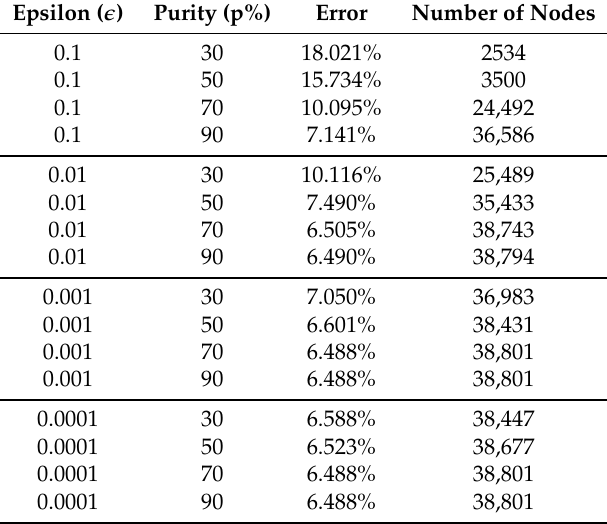
Table 1. The result of errors and number of found nodes using different values for (cid:101) and purity. The dimension of the blocks was